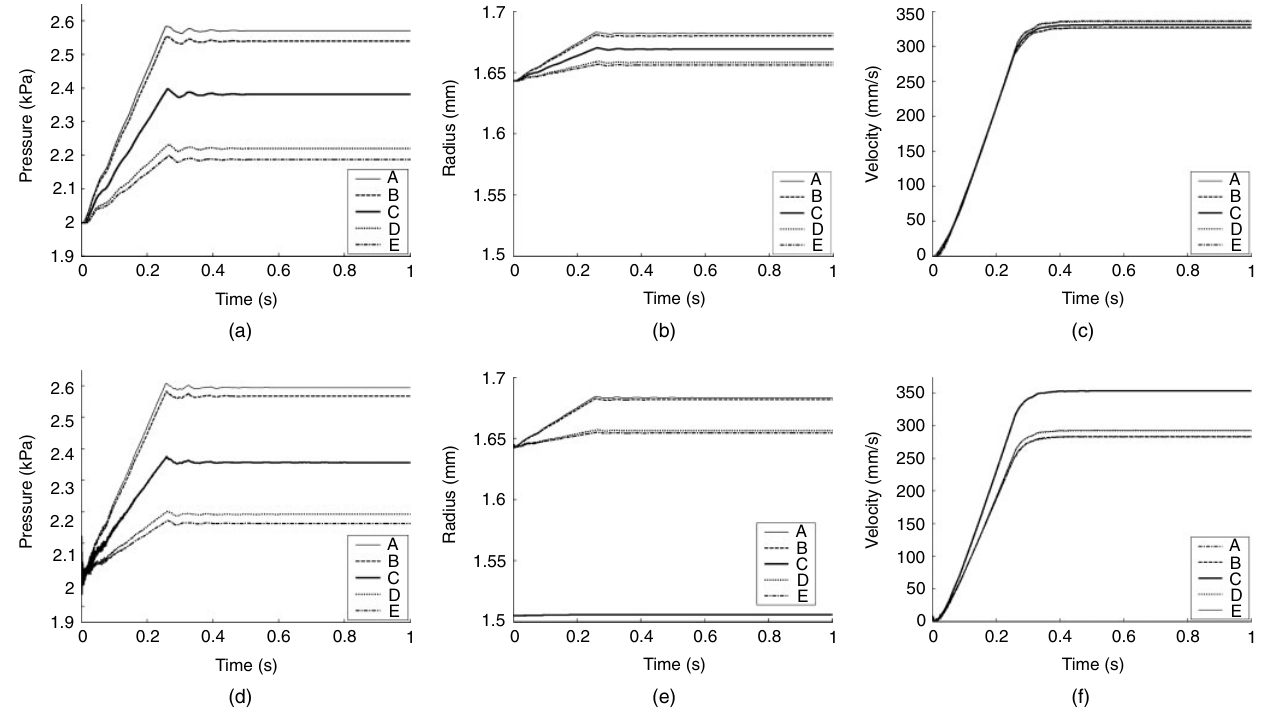
Figure 3 Time versus varying pressure, radius and flow velocity at various points (A–E) along the vessel segment 2 in the unstented ((a)–(c)) and stented ((d)–(f)) cases with linear increase in inlet pressure (Simulation I). See Figure 1 for the positions of these points in the network. Note that the radius at point C in the middle of the stented vessel is just over 1.5 mm (the radius of the